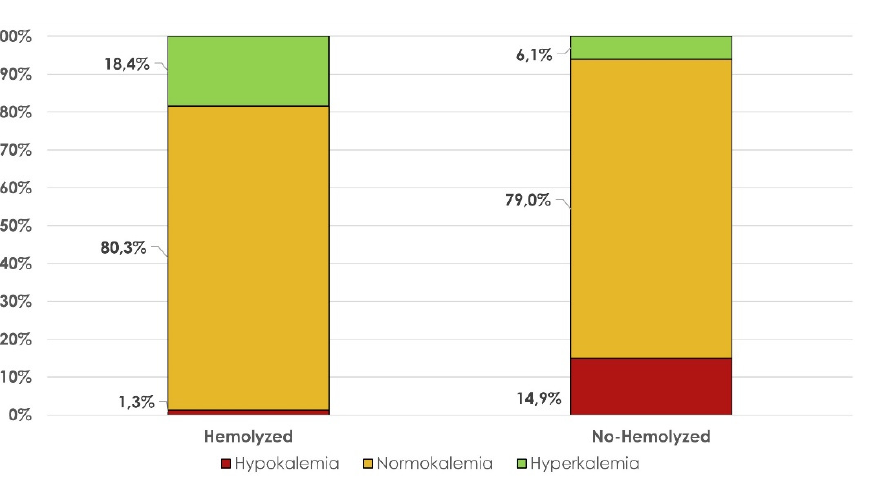
Figure 5. Distribution of hypo-, normo-, and hyperkalemia among hemolyzed and non-hemolyzed samples.